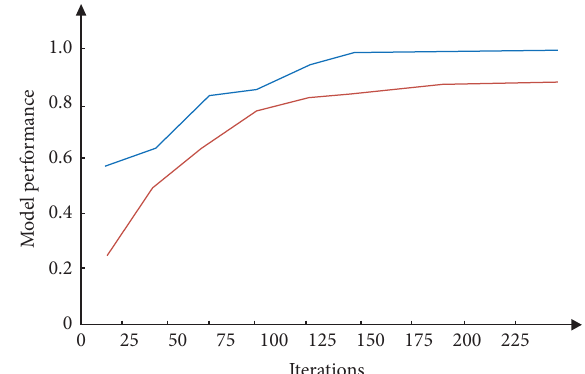
Figure 5: Relationship between training rounds and model